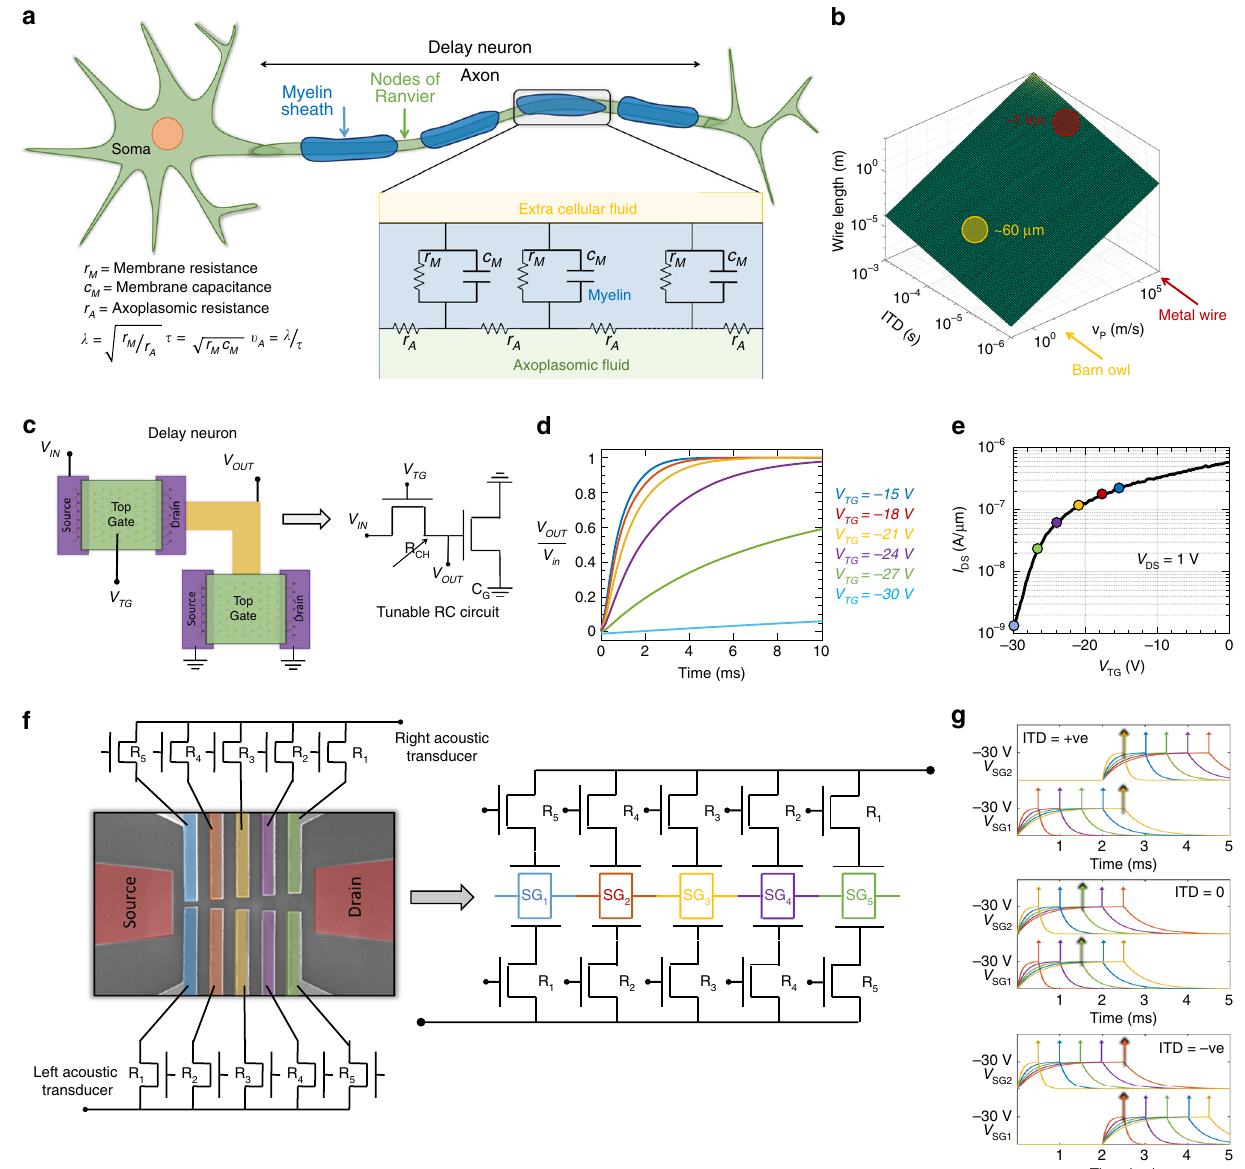
Fig. 4 Arti fi cial time delay neuron. a Schematic of a vertebrate axon and its equivalent circuit representation following the distributed transmission line model. The length constant ( λ ) determines how far the action potential can propagate without regeneration, and, the time constant ( τ ) determines how fast the action potential can propagate, resulting in a fi nite axonal conduction velocity v A = λ / τ . b Length of delay line required for mapping the ITDs as a function of the signal propagation velocity ( v p ). The axonal conduction velocity in barn owl is 3 – 5 m/s translating into few tens of μ m axonal length required for mapping the ITDs, whereas metallic interconnects will require impractical wire lengths necessitating the introduction of delay elements into biomimetic device. c Schematic of an arti fi cial delay neuron realized by connecting the gate terminal of one MoS 2 FET to the drain terminals of another MoS 2 FET. The gate capacitance (C G ) and channel resistance ( R CH ) of the corresponding MoS 2 FETs construct a tunable RC circuit. d Experimental transient responses of solid state delay neuron with tunable time constants or delays ( τ c ) achieved through different top-gate biases applied to the resistive MoS 2 FET. e Transfer characteristics of the resistive MoS 2 FET at V DS = 1 V. f Fully integrated biomimetic audiomorphic architecture. The resistances of the MoS 2 FETs connected to the bottom halves of the split-gates increase monotonically from left to right and vice versa for the top halves of the split-gates. g Each split-gate is charged in response to audio cues. The spikes mark the times when the respective gates reach their peak negative potential. Color coding shows that the coincidence occurs at the central split-gate (green) for ITD = 0, and on the right side (yellow) for positive ITD and left side (red) for negative ITD